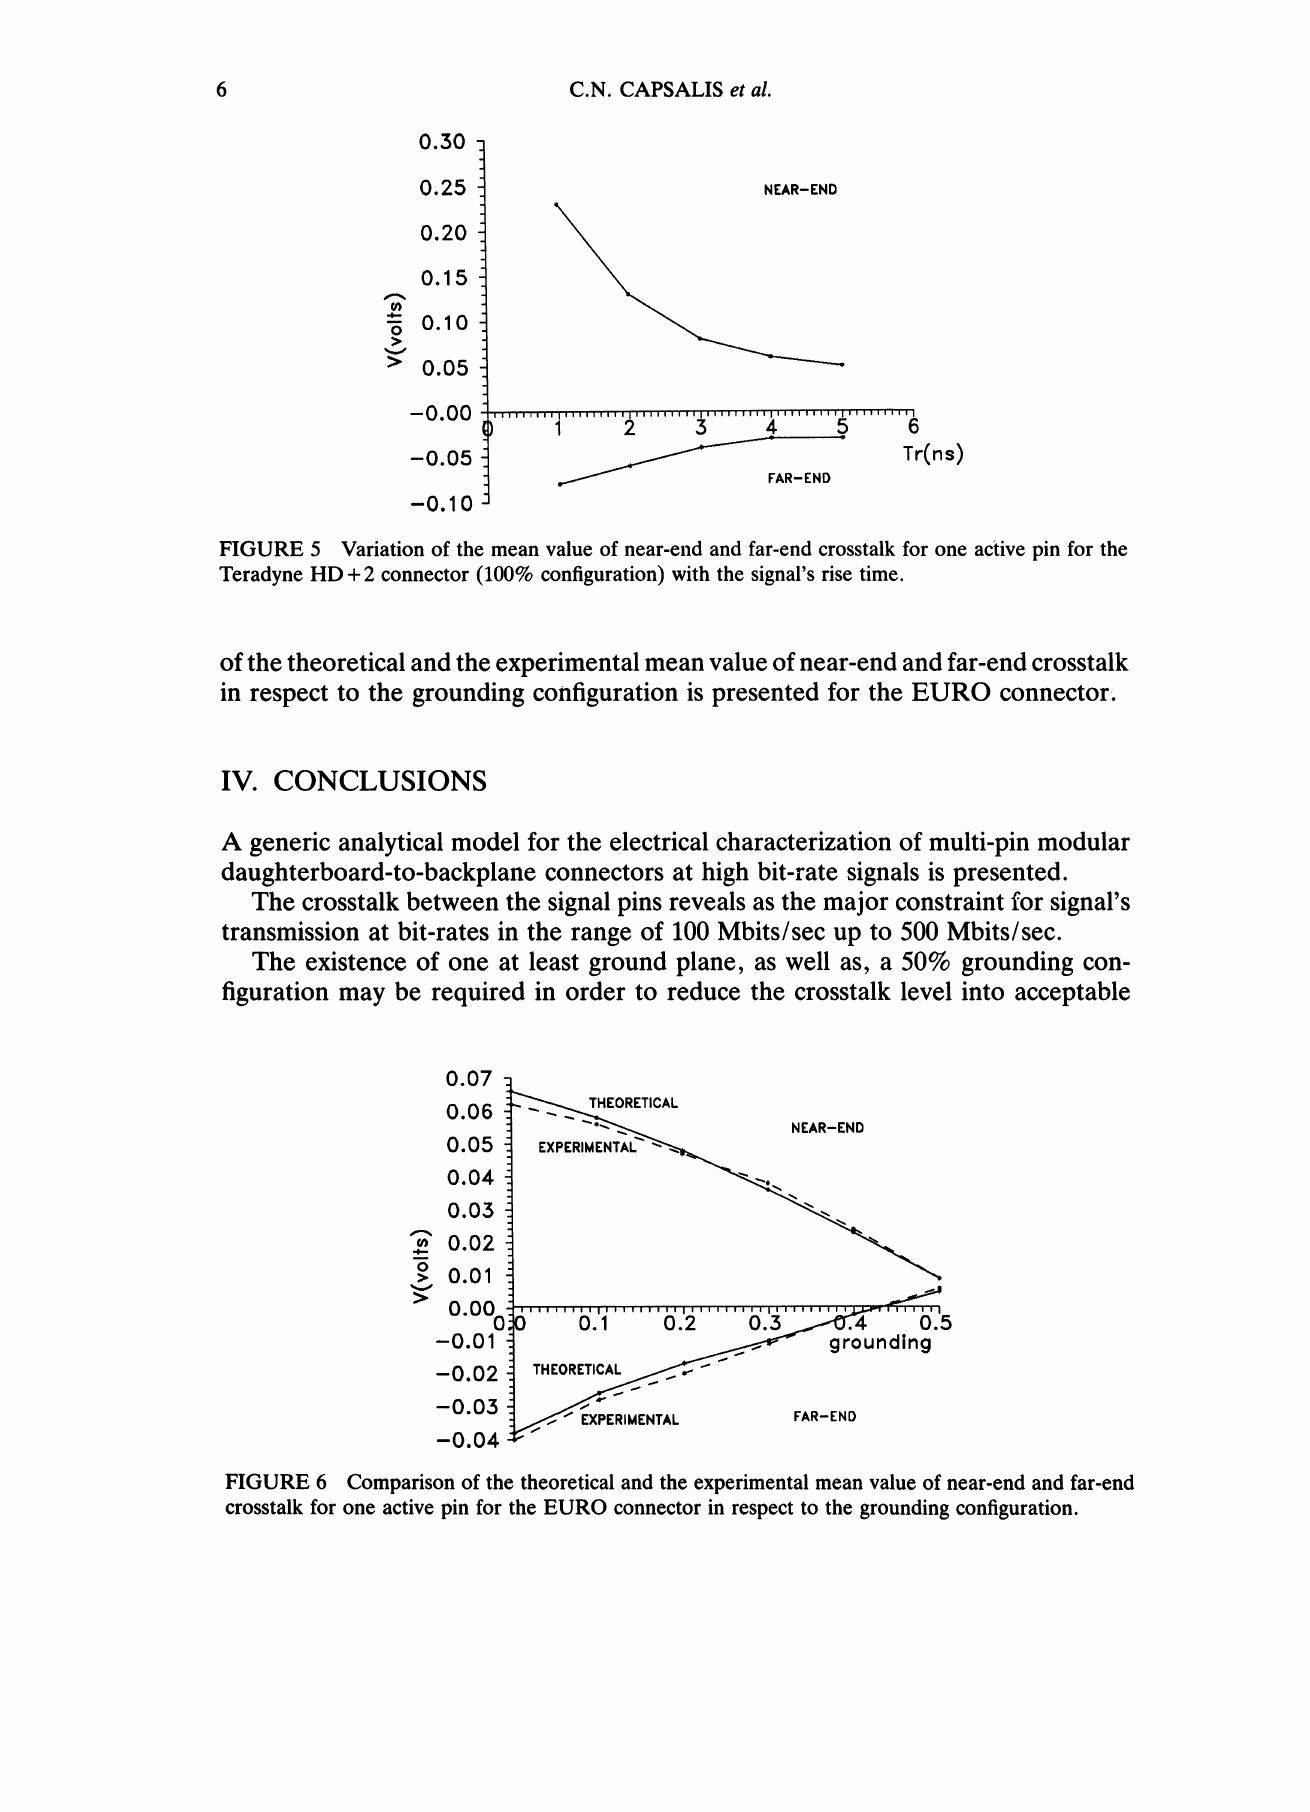
FIGURE 6 Comparison of the theoretical and the experimental mean value of near-end and far-end crosstalk for one active pin for the EURO connector in respect to the grounding